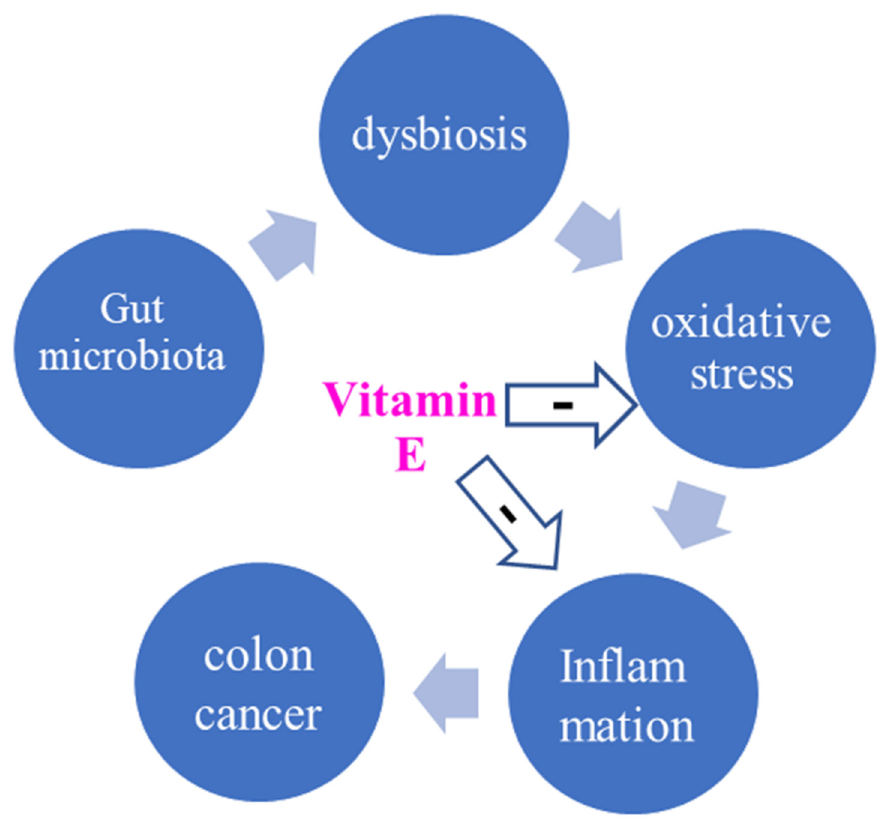
Figure 2. Microbiota-colon cancer loop: the probable modulating effect of Vitamin E.